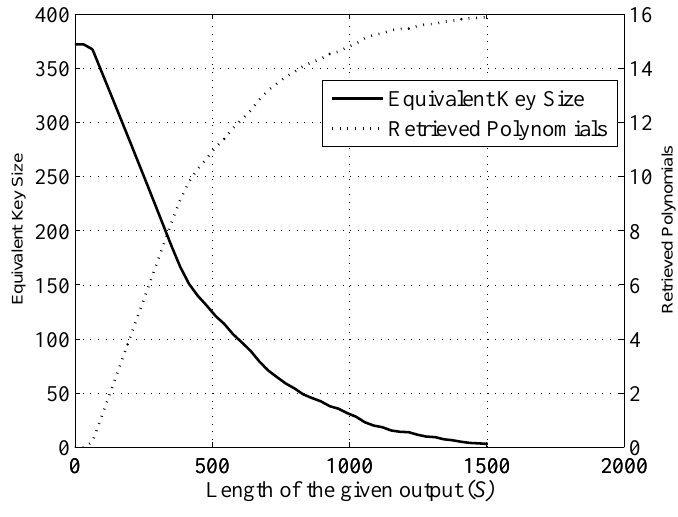
Figure 4. Results of the cryptanalysis for m = 16 , n = 32 and l = 31